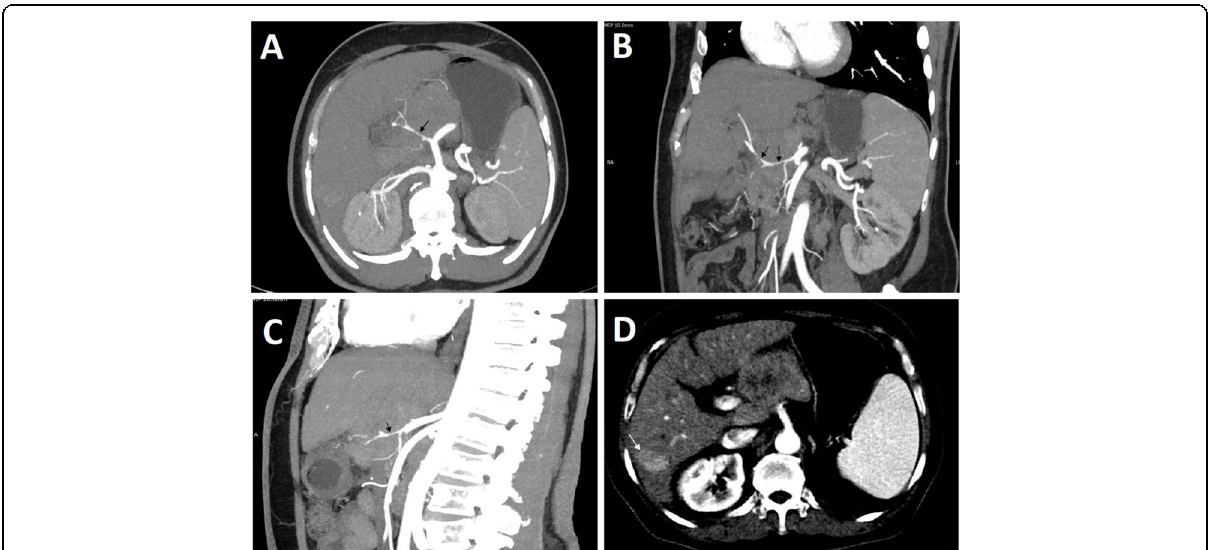
Fig. 4 ( A ) Axial MDCT with ( B ) coronal and ( C ) sagittal reformation (MIP arterial phase) in a 78 years old man shows a pancreatic body mass encasing the CHA (black arrows in A , B , C ), with hepatic metastasis (white arrow in D ) which are CT signs of definite unresectability (true negative